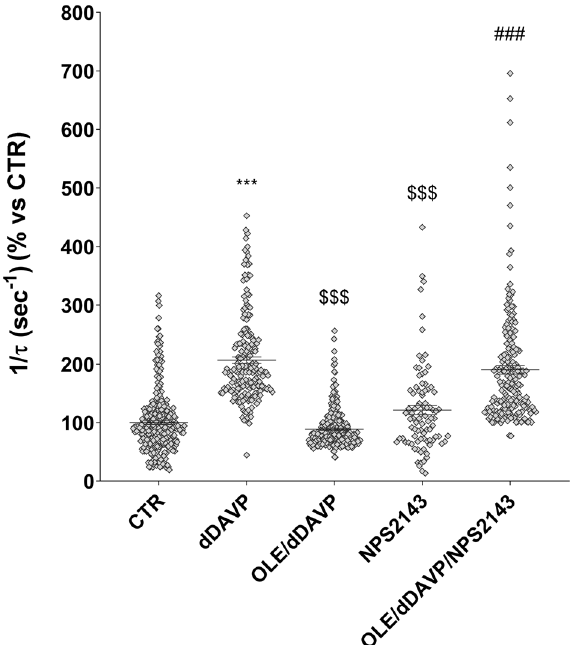
Figure 5. Effects of OLE on AQP2 function in MCD4 cells under CaSR inhibition by NPS2143. Osmotic water permeability was measured in MCD4 cells, loaded with Calcein-AM (10 μM for 45 min) as described in methods. Cells were stimulated with dDAVP (100 nM for 30 min), OLE (0.1 mg/ml O/N) and NPS2143 (1 µM O/N). Alternatively, cells were co-treated with OLE/dDAVP or OLE/dDAVP/NPS2143. The temporal osmotic response is indicated as 1/τ (expressed in sec −1 ). Data are shown as single values in a scatter plot reporting